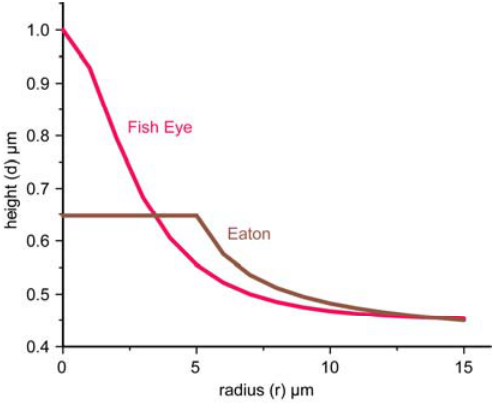
Figure 8. Typical profiles of a microdroplet which emulates either the fisheye lens (R = 7  m) or the inverted Eaton lens (R = 5  m) for the following set of parameters: l = 1, = 1.5, and n =  m, n d 1